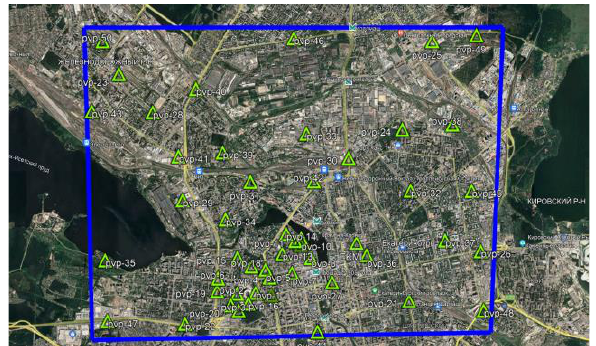
Figure 4 . The experimental area and ground check